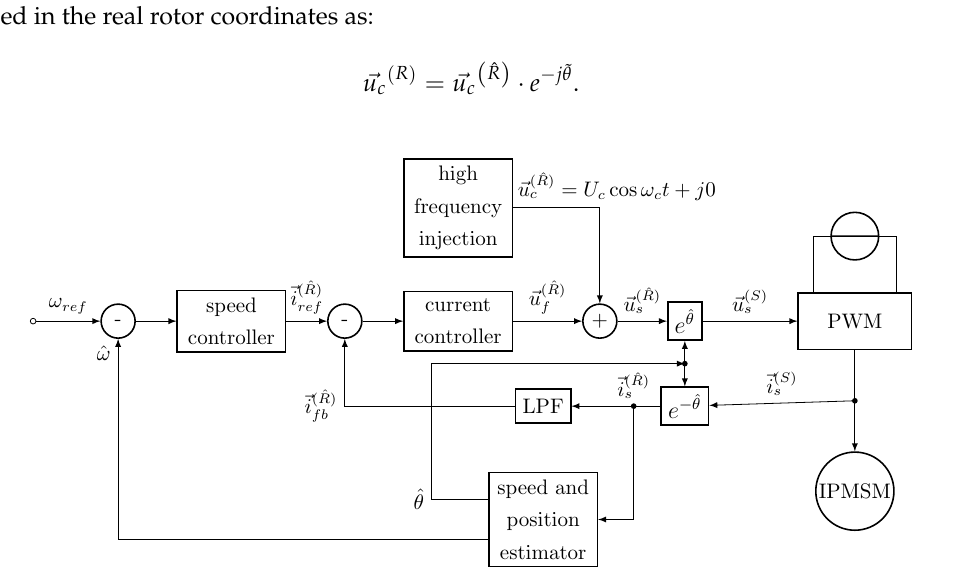
Figure 3. Block diagram of the proposed sensorless